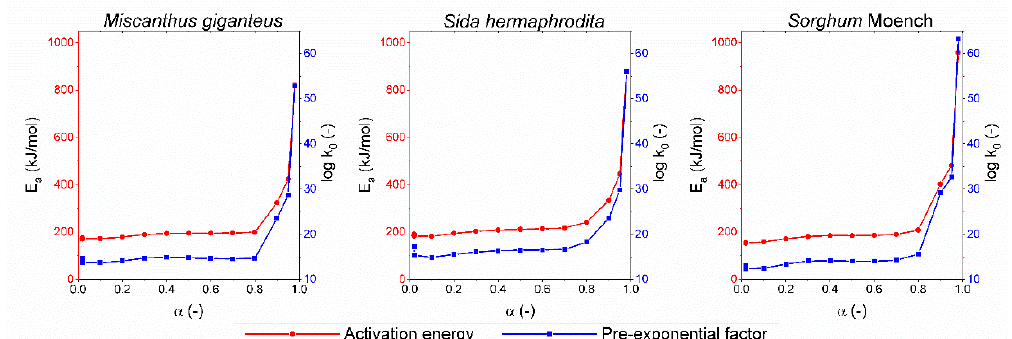
Figure 4. Ozawa–Flynn–Wall plots for energy crop